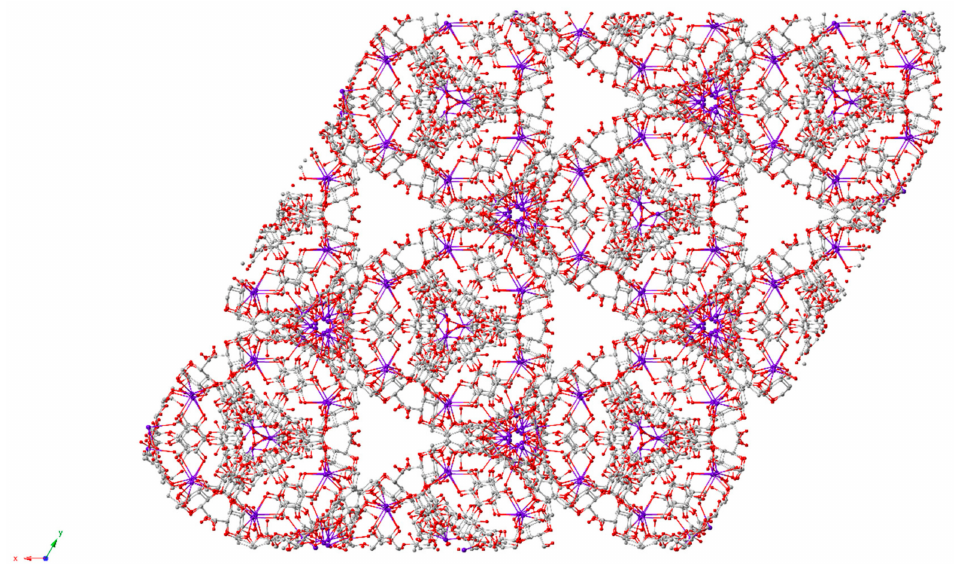
Figure 3. Space-filled representation of the extended solid-state structure of CD-MOF-1 where C is grey, O is red and K is purple